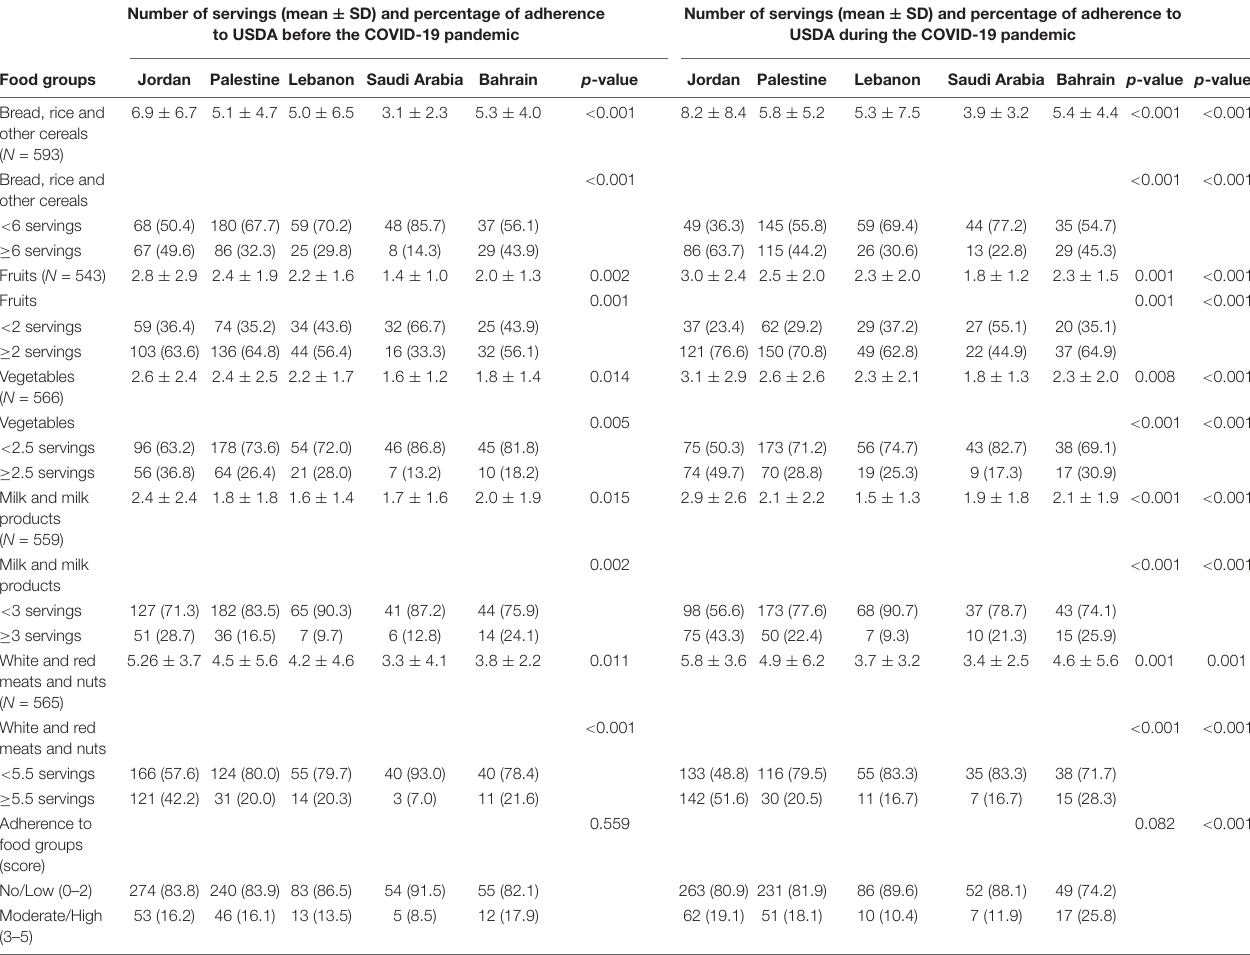
TABLE 3 | Number of servings consumed per day and adherence to United States Department of Agriculture (USDA) recommendations of the major food groups consumed by pregnant women before and during the coronavirus disease-19 (COVID-19) pandemic, by country. Number of servings (mean ± SD) and percentage of adherence Number of servings (mean ± SD) and percentage of adherence to to USDA before the COVID-19 pandemic USDA during the COVID-19